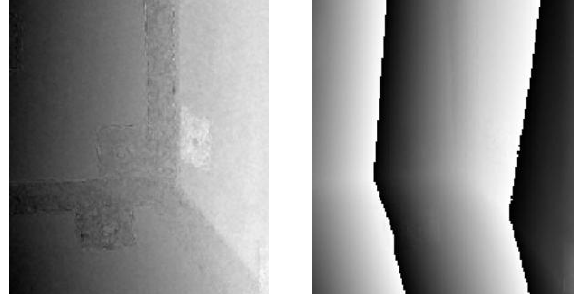
Figure 4. Phase maps of a dark flat target with 1/64 pixel (right) and 1/2048 pixel (left) spatial frequencies